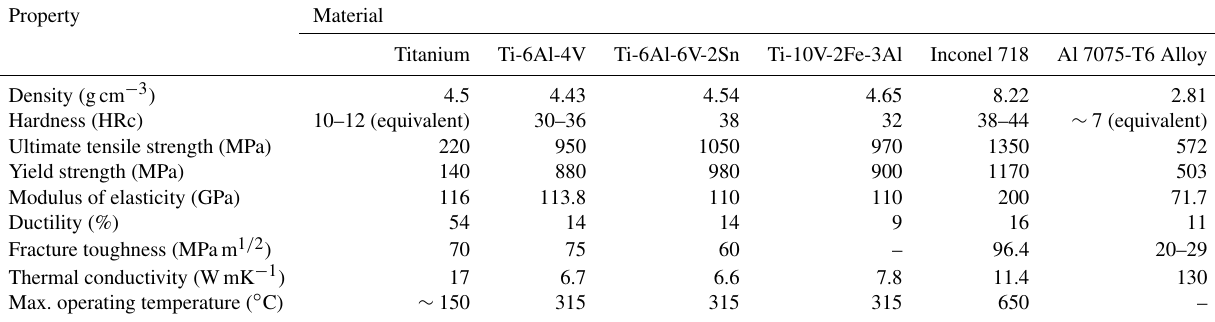
Table 1. Comparison of room temperature properties of aerospace alloys (Jaffery et al., 2013; Jaffery and Mativenga, 2012; Hughes et al.,